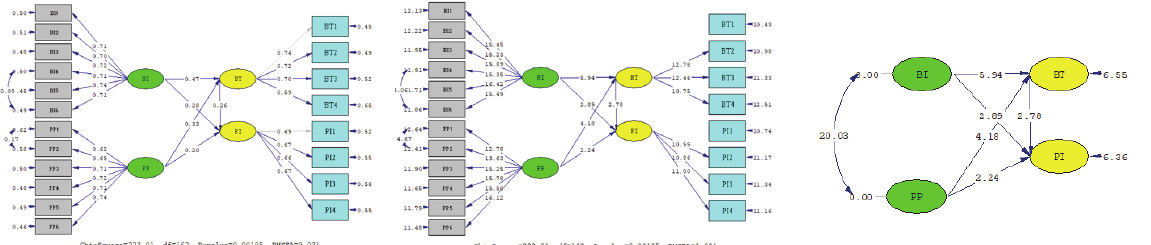
Fig. 3. SEM Analysis Results Fig. 4. SEM Analysis T- Score Results Fig. 5. Structural Equation Modelling